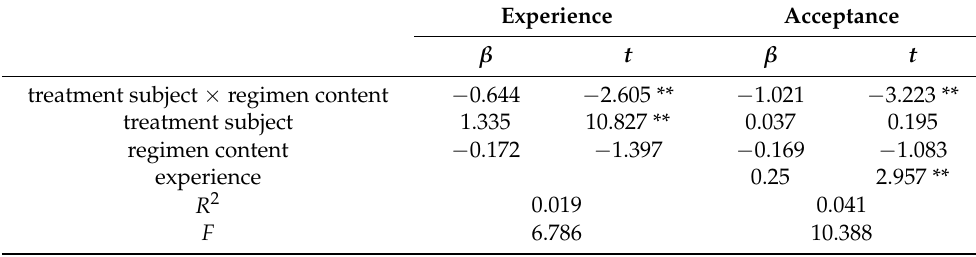
Table 5. Mediated model tests with moderation.